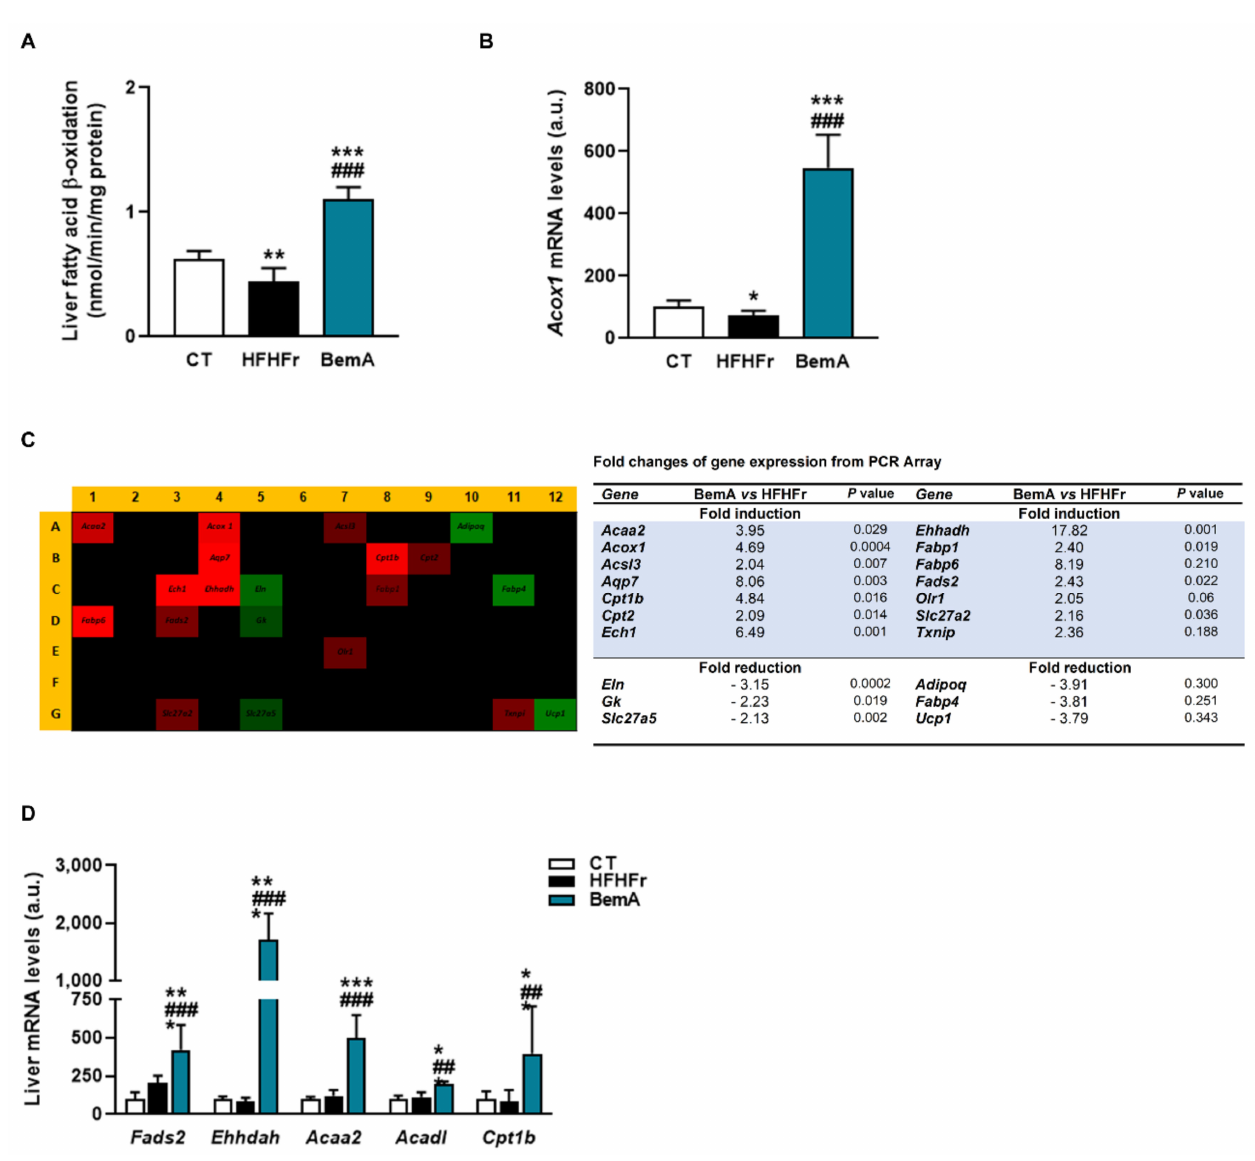
Figure 7. Bempedoic acid increases fatty acid β -oxidation in the liver. ( A ) β -oxidation activity in liver samples from control (CT), high-fat, high-fructose (HFHFr), and bempedoic acid (BemA) groups. ( B ) The mRNA levels of Acox in liver samples from CT, HFHFr, and BemA groups. ( C ) Heat map of PCR array showing differential expression of 84 PPAR-responsive genes in liver samples. The heat map represents fold regulation expression between HFHFr and BemA liver samples. Genes with higher expression in BemA samples compared to HFHFr are depicted in red, and genes with lower expression are depicted in green. On the right side of the figure, a table shows the name of the genes induced or repressed more than two-fold, and the p value obtained after the statistical analysis using Student’s t -test. ( D ) Validation by RT-PCR of genes related to fatty acid peroxisomal ( Fadss2 , Ehhadh ) and mitochondrial ( Acaa2 , Acadl, and Cpt1b ) β -oxidation in CT, HFHFr, and BemA liver samples. The results are expressed as the mean ± SD of 7–8 animals/group. a.u.: arbitrary units. Data were analyzed by one-way ANOVA, followed by Tukey’s post-hoc * p < 0.05, ** p < 0.01, *** p < 0.001 compared to CT; ## p < 0.01 ### p < 0.001 compared to